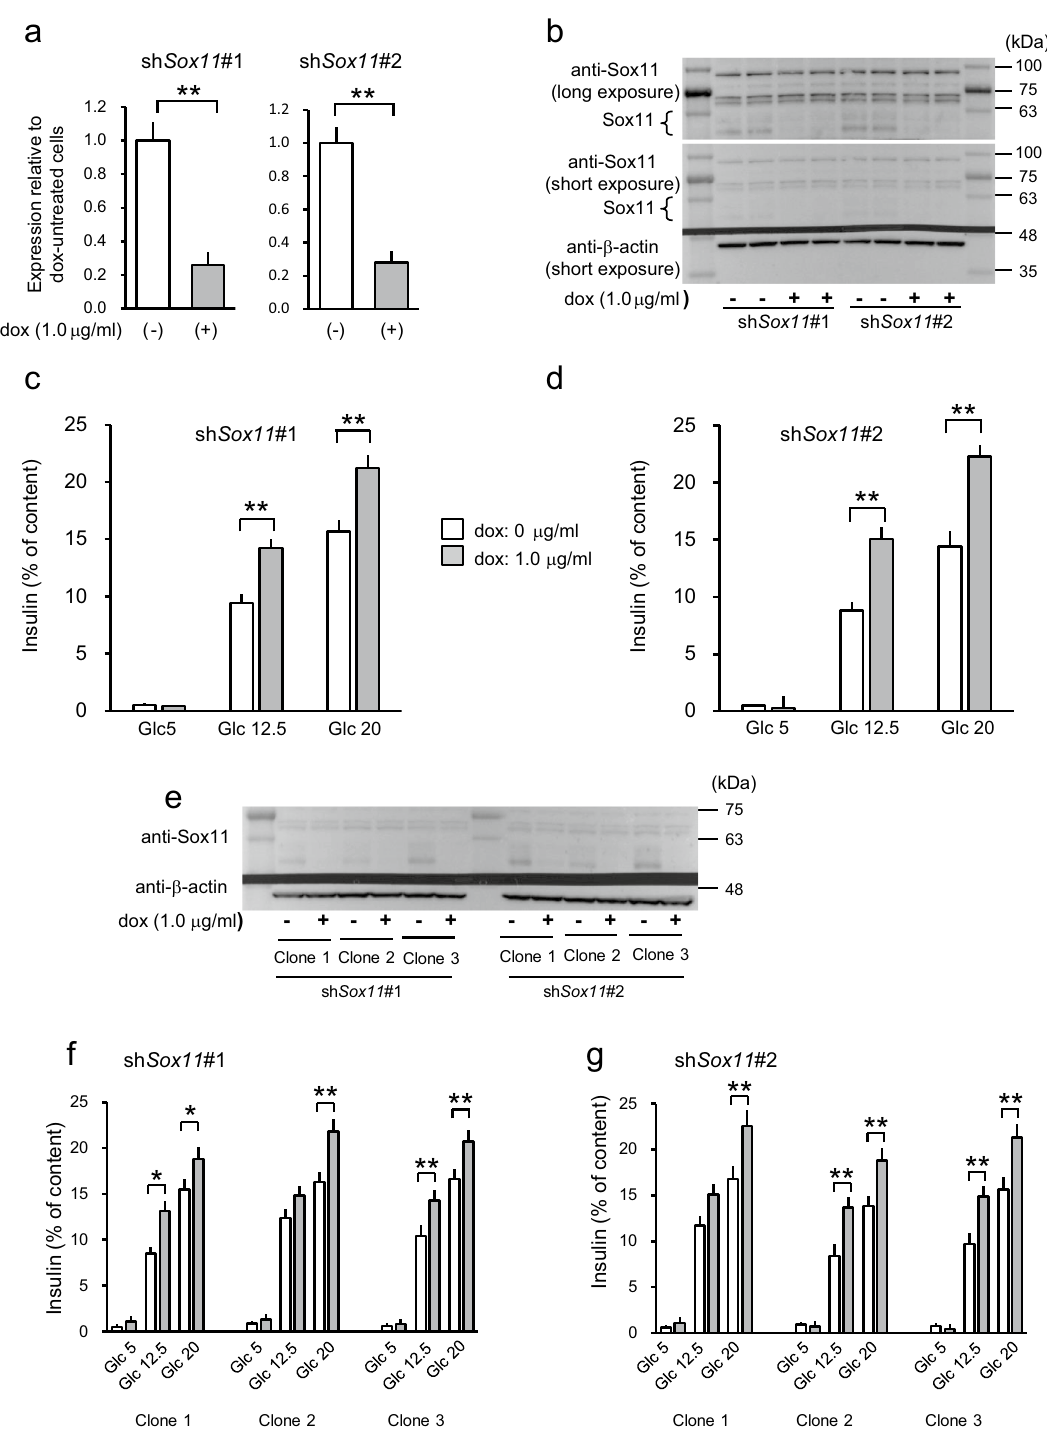
Figure 5. Effects of suppression of Sox11 expressions on insulin secretion. ( a ) RT-PCR analyses of the effects of expressing two different shRNAs for targeting Sox11, sh Sox11 #1 and sh Sox11 #2 . Data are means ± SEM, n = 3 experiments. ** P < 0.01. ( b ) MIN6 cells harboring the tetracycline-dependent shRNA against Sox11 expression unit (sh Sox11 #1 and sh Sox11 #2) were cultured with 1 μg/ ml of dox for 6 days and subjected to Western blot analysis. Membranes were analyzed as described in the legend for Fig. 4a. Shown is the representative blot from 3 experiments. Uncropped images are presented in Supplementary Fig. S4. ( c , d ) Glucose-stimulated insulin secretion from cells with reduced expressions of Sox11, sh Sox11 #1 ( c ) and sh Sox11 #2 ( d ). Data are means ± SEM, n = 3 experiments. ** P < 0.01. White bars represent dox-untreated control cells and grey bars dox (1 μg/ml) -treated shRNA expressing cells. ( e ) Western blot analyses were performed using subclones expressing sh Sox11 #1 and sh Sox11 #2 as described in ( b ). Shown is the representative blot from 2 experiments. Uncropped images are presented in Supplementary Fig. S6. ( f , g ) Glucose-stimulated insulin secretion from subclones with reduced expressions of Sox11, sh Sox11 #1 ( f ) and sh Sox11 #2 ( g ). Data are means ± SEM, n = 3 experiments. * P < 0.05, ** P < 0.01. White bars represent dox-untreated control cells and grey bars dox (1 μg/ml) -treated shRNA expressing